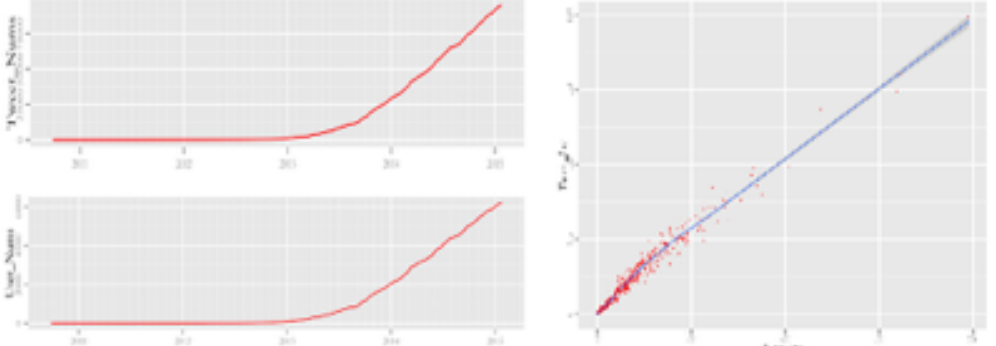
Figure 1: The number of MOOC postings and the number of users contributing MOOC